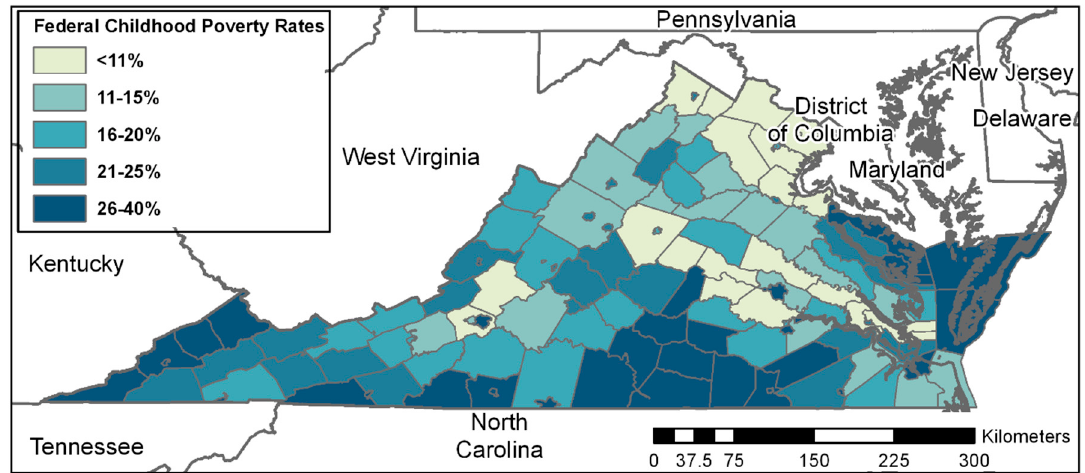
Figure 1. Childhood poverty rates in Virginia (% below federal poverty line). 101